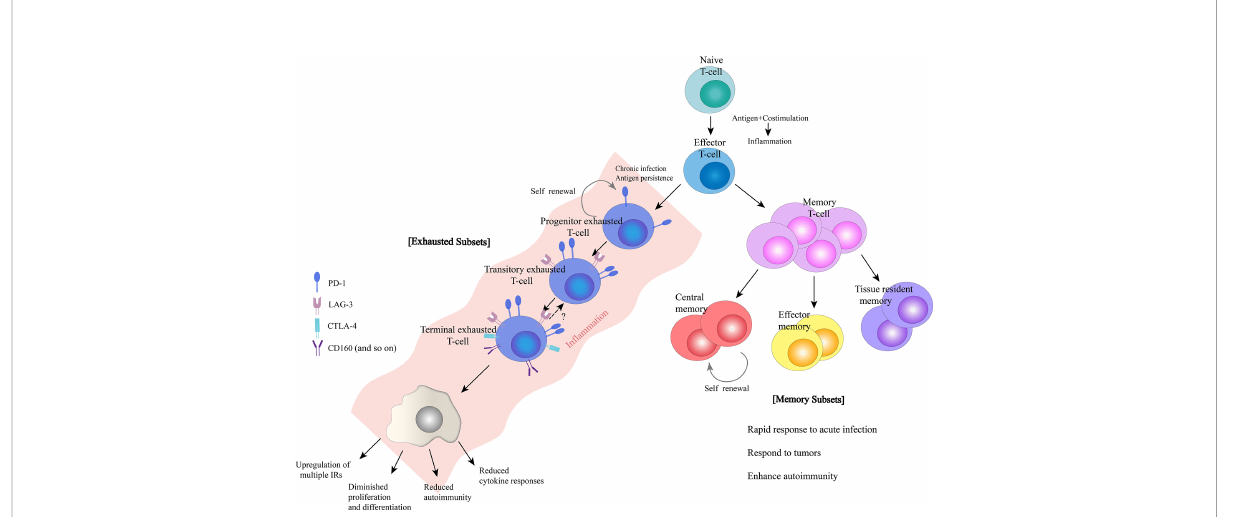
FIGURE 1 Characteristics of exhausted and memory T-cells. Naïve T-cells differentiate into effector T-cells, and then, a subset of effector T-cells differentiate into memory T-cells. In addition, in the presence of chronic infection and antigen persistence, T-cells may become exhausted. Both memory and exhausted T-cells have distinct subsets during differentiation that work together to perform their respective effector